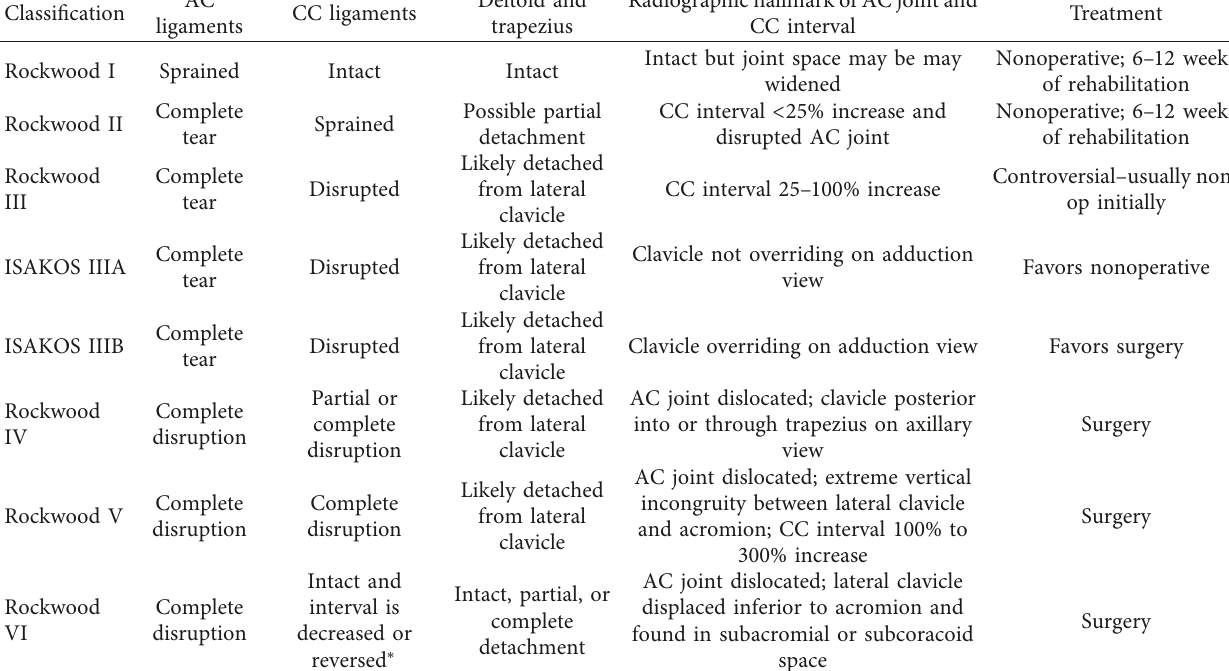
Table 1: Rockwood and ISAKOS classifications for AC joint